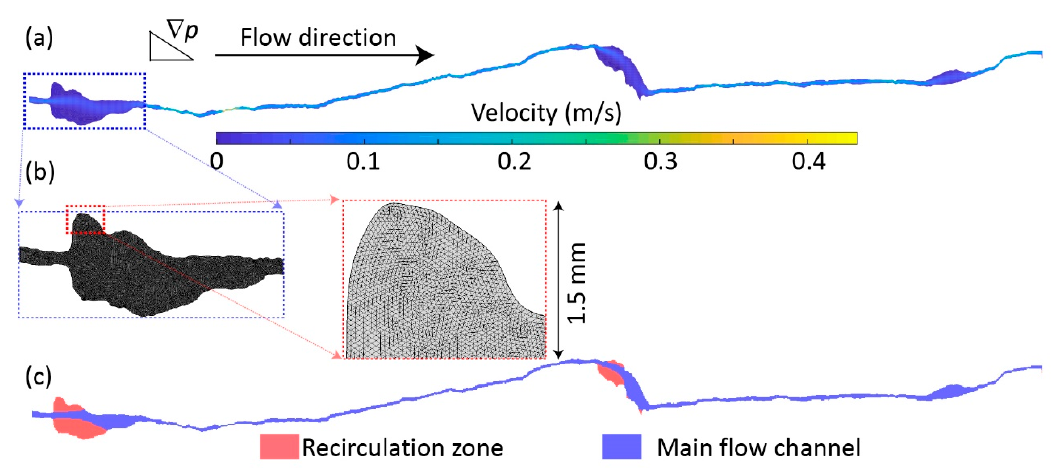
Figure 1. ( a ) The flow field driven by the pressure gradient ( ∇ p ) from left (upstream) to right (downstream) with velocity magnitude illustrated by the filled color. ( b ) A typical segment of fracture showing the mesh scheme used for computational fluid dynamics. ( c ) The recirculation zone (red zone) induced by significant inertial effects and main flow channel (blue zone) are delineated by the code proposed by [23].